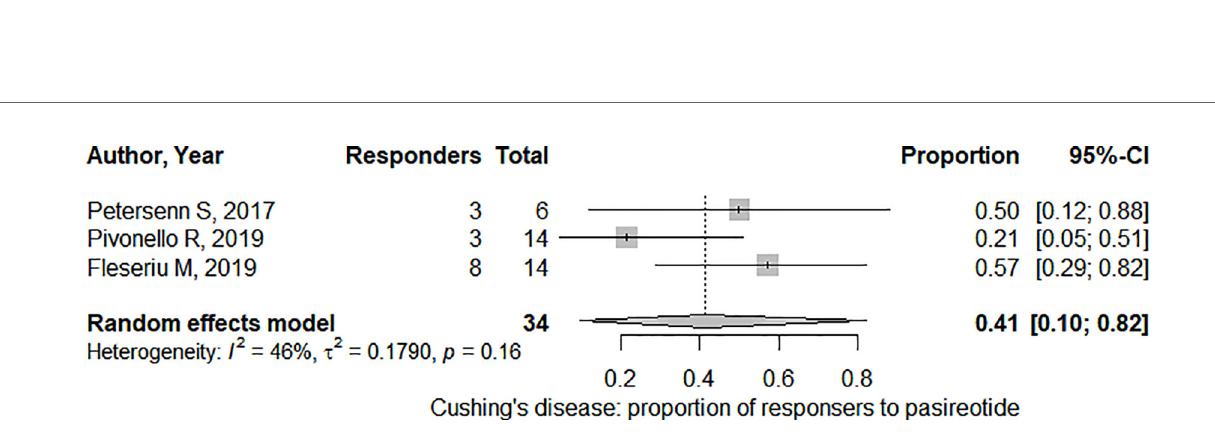
FIGURE 4 | Pooled effect for the proportion of responders (i.e. presenting signi fi cant tumor shrinkage) in acromegaly. CI, con fi dence interval.